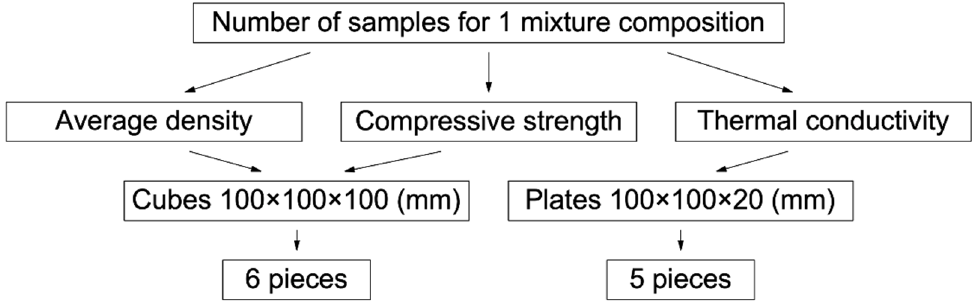
Figure 1. Experimental research program.